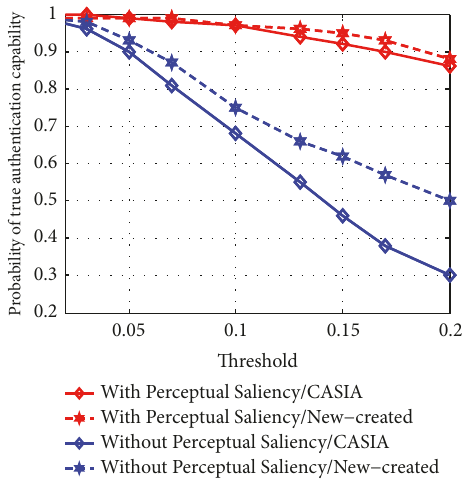
Figure 5: The probability of true authentication capability for tamper detection for CASIA/newly created database with/without perceptual